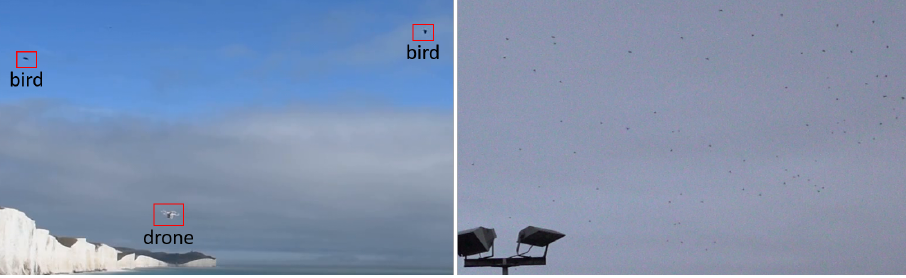
Figure 4. Examples with birds that are the main disturbing